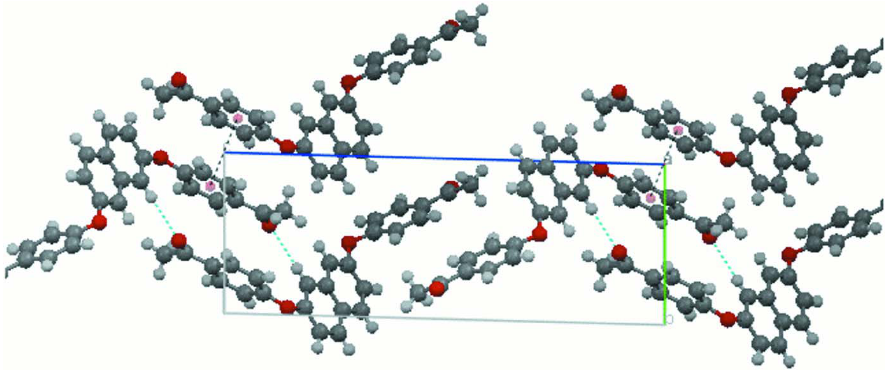
Figure 2 The crystal packing of the title compound, viewed down the a axis. The dashed lines indicate hydrogen bonding (blue dashed line) and π — π stacking interactions (black dashed